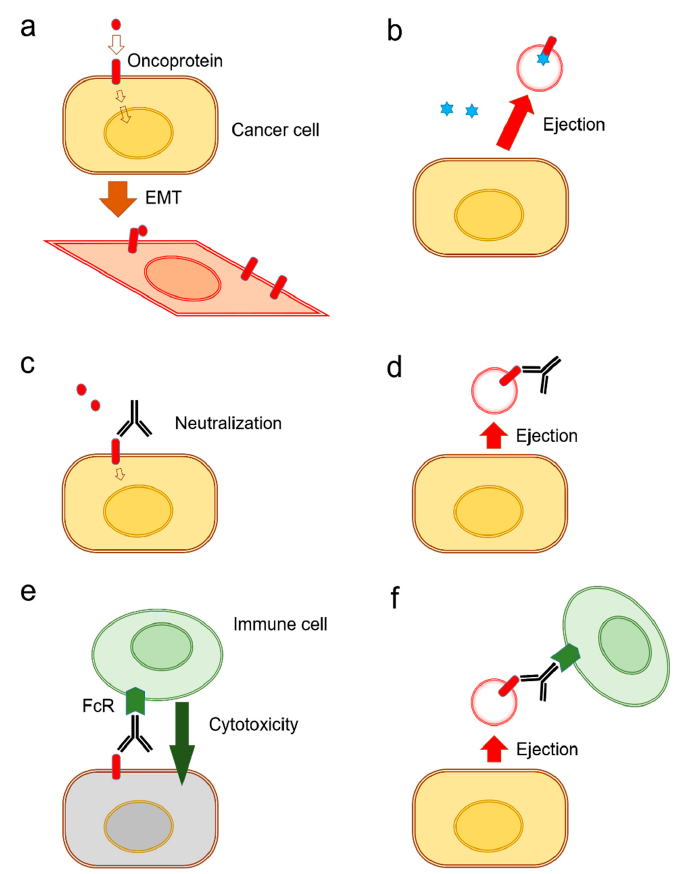
Figure 3. Exosome release mechanisms for the ejection of drugs and antibodies. ( a ) Cancer cells and CSCs/CICs express oncoproteins, such as mutant or amplified EGFR, whose transmembrane signaling promotes the progression of cancer cells, e.g., EMT [31]. Yellow: a round-shaped cell, before EMT. Red: a diamond-shaped cell, after EMT. ( b ) Cancer cells can eject molecularly-targeted drugs (blue stars). ( c ) Neutralization of ligand-receptor interaction is a major mechanism of action of antibody-based agents. Activities of cell-surface oncoproteins can be neutralized and inhibited by host-derived endogenous antibodies and molecularly-targeted antibody drugs [37]. ( d ) Cancer cells can eject molecularly-targeted antibodies by releasing exosomes that contain oncoproteins as RASP [37]. Meanwhile, cancer cells can further transform and acquire resistant phenotypes. ( e ) The antibodies are also recognized by FcR of immune cells, including phagocytes and NK cells. ( f ) Cancer cells can also become resistant to immune cells by releasing